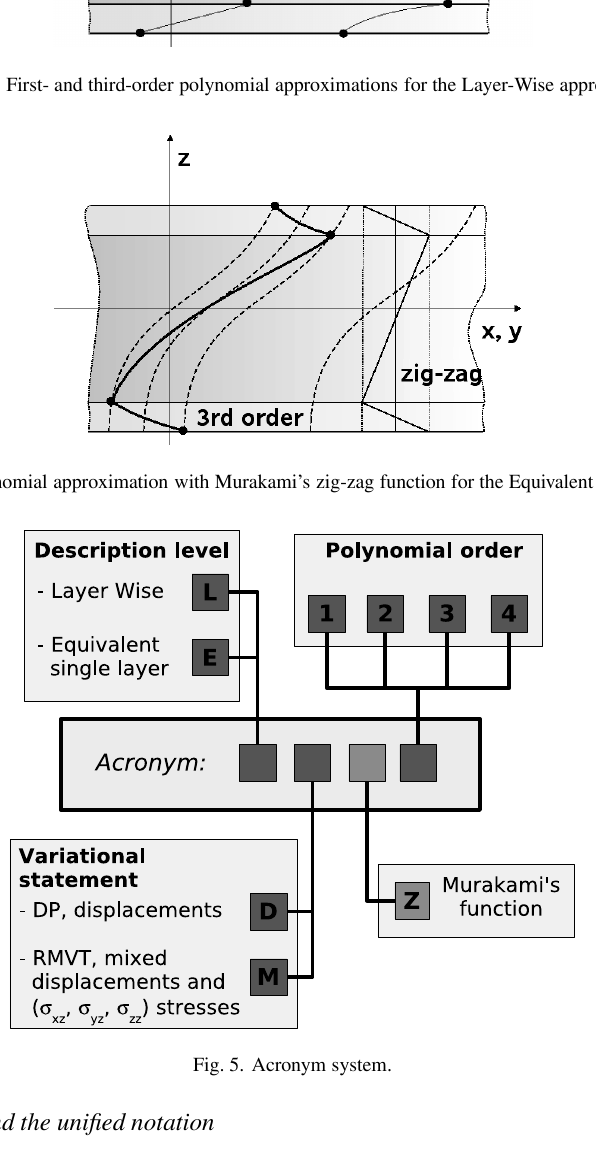
Fig. 5. The fi rst letter, either ‘L’ or ‘E’, speci fi es whether a LW or an ESL approach is assumed. The second letter indicates the variational statement: ‘D’ for DP or ‘M’ in the case of RMVT. The number represents the